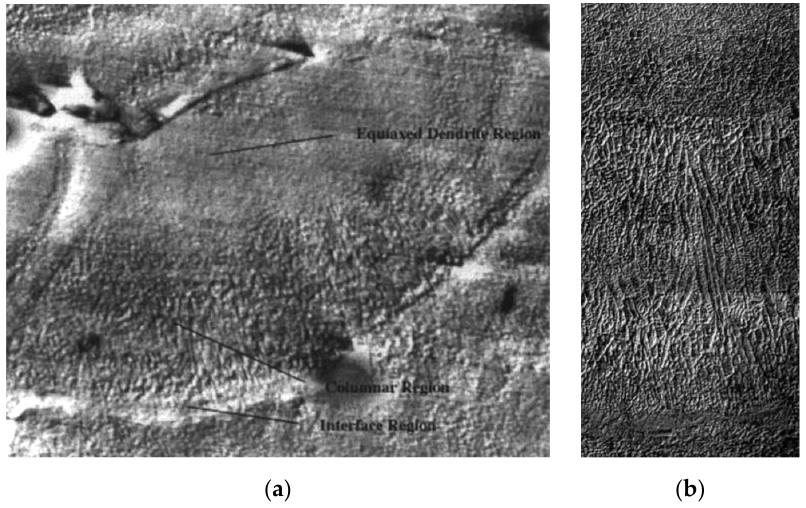
Figure 29. ( a ) Cross-section of H13 tool steel deposit and ( b ) close-up of deposition pass characterized by three-zone: interface region, columnar region, and equiaxed dendrite region (reproduced with permission from [128]; Copyright © 1999 Springer Nature).